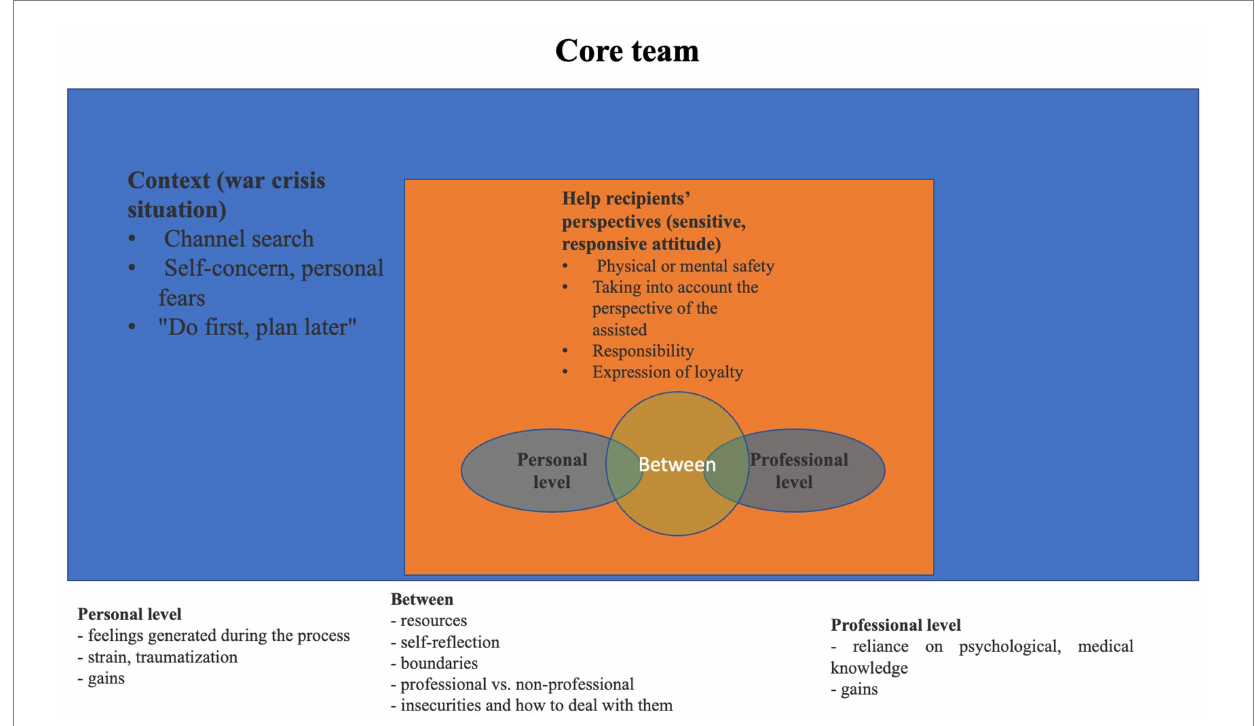
FIGURE 1 Results of the consensual content analysis—the categories established from the core team topics and the relationships among them.